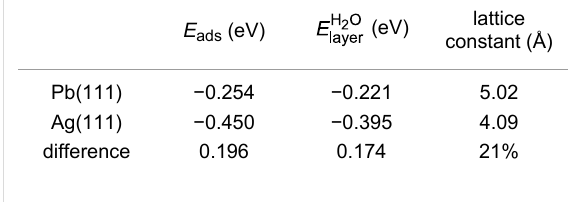
Table 1: Calculated adsorption energies of water layers at a coverage of 2/3 on Pb(111) and Ag(111) compared to the binding energies of free-standing water layers in the corresponding adsorption